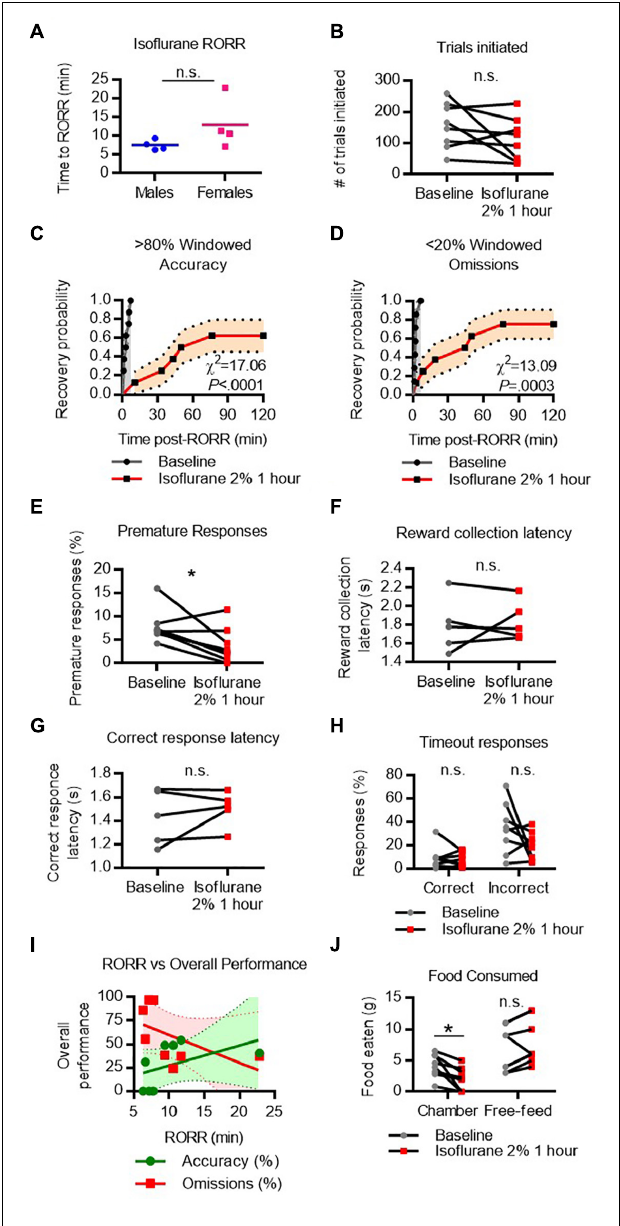
FIGURE 3 | Performance on the 5-CSRTT following isoflurane. (A) Return of righting reflex (RORR) following 1 h of 2% isoflurane in male and female rats. (B) Total number of 5-CSRTT trials initiated at baseline and following isoflurane anesthesia. (C,D) Probability of achieving > 80% windowed accuracy (C) and < 20% windowed omissions (D) at baseline and following isoflurane by the indicated time. (E–H) Difference in premature responses (E) , reward collection latency (F) , correct response latency (G) , and timeout responses to correct and incorrect windows (H) at baseline and following isoflurane. (I) RORR latency vs. overall accuracy (green) and omission (red) performance following isoflurane anesthesia. Regression slope (solid line) and 95% confidence interval (dashed lines) indicated. (J) Total weight of food eaten in the chamber during the task and following the task during the free-feeding period at baseline and following isoflurane. n.s., not significant; * P < 0.05, N = 8.